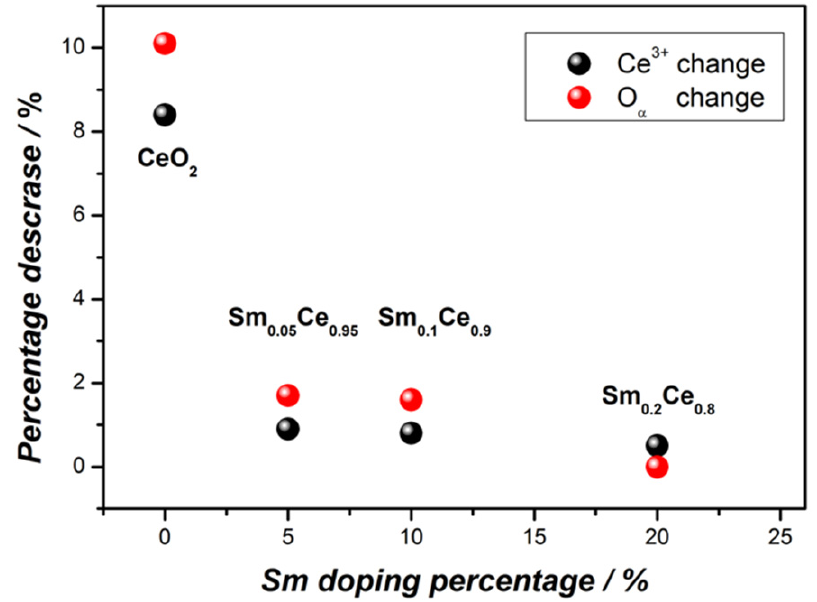
Figure 10. Relationship between Ce 3+ /O α change and Sm-doping ratio.